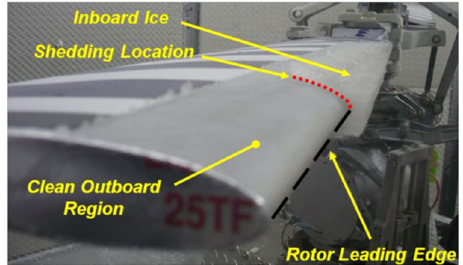
Figure 4. Ice shedding observed in [75] (Reproduced with permission from Brouwers, E).